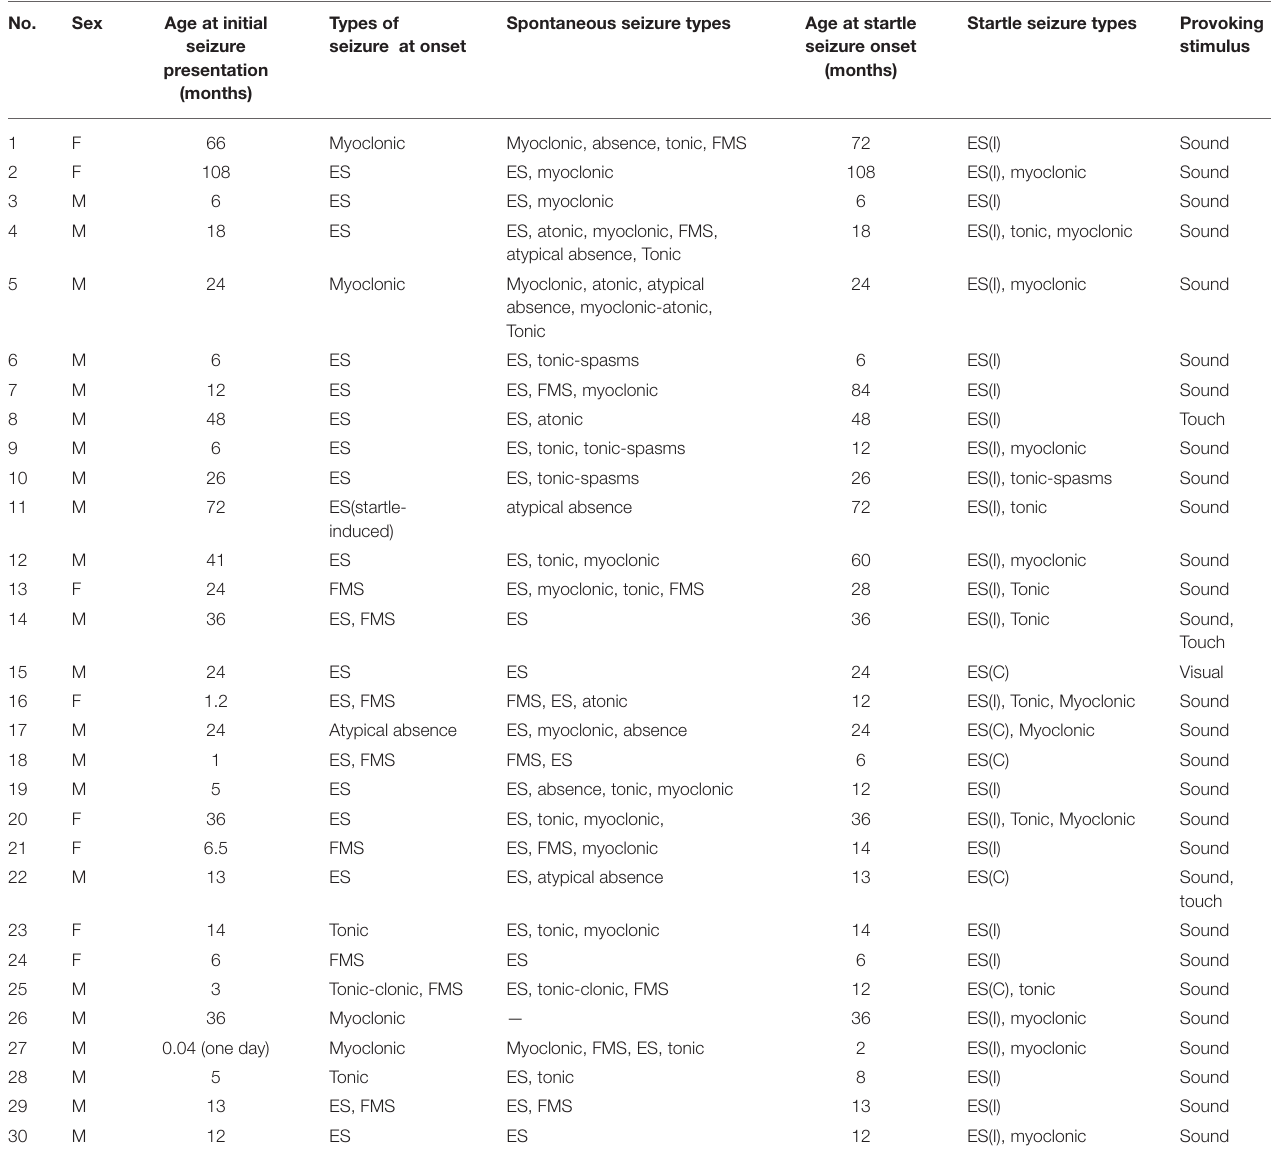
TABLE 4 | Seizure